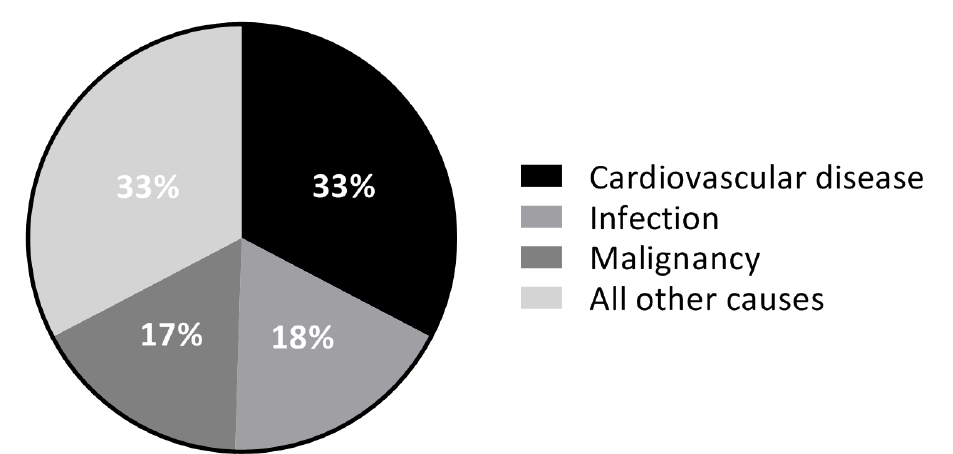
Figure 3. Mortality by causes of death with graft function in US KTR in 2015. This figure shows that cardiovascular disease was the leading cause of mortality among US KTR in 2015. Cardiovascular disease included acute myocardial infarction, atherosclerotic heart disease, congestive heart failure, cerebrovascular accident, and arrhythmia/cardiac arrest. Adapted from USRDS 2018 Annual Data Report [4].